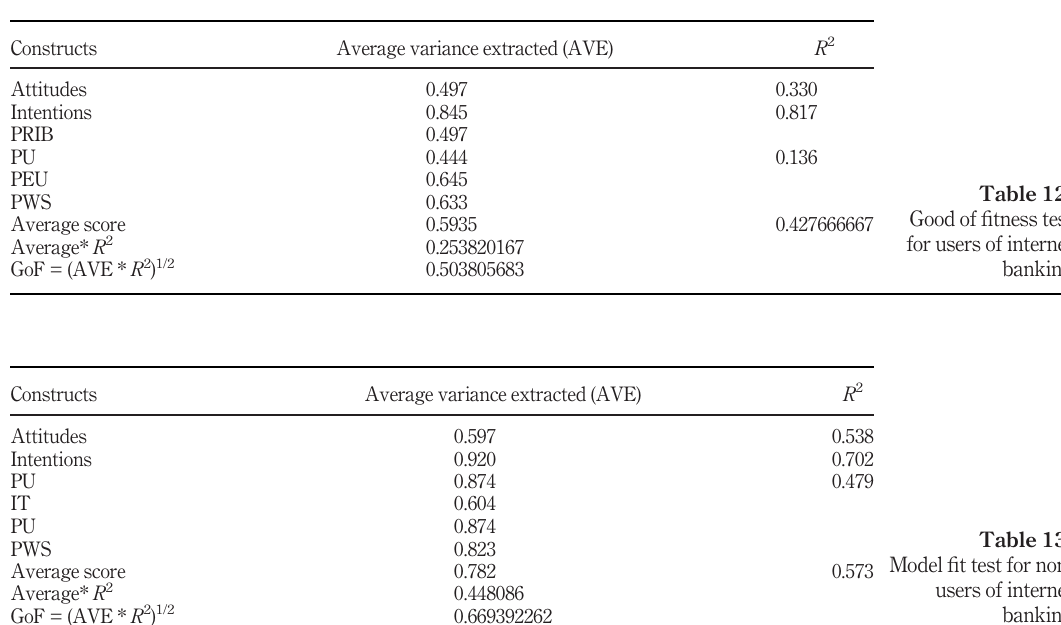
Table 13. Model fi t test for